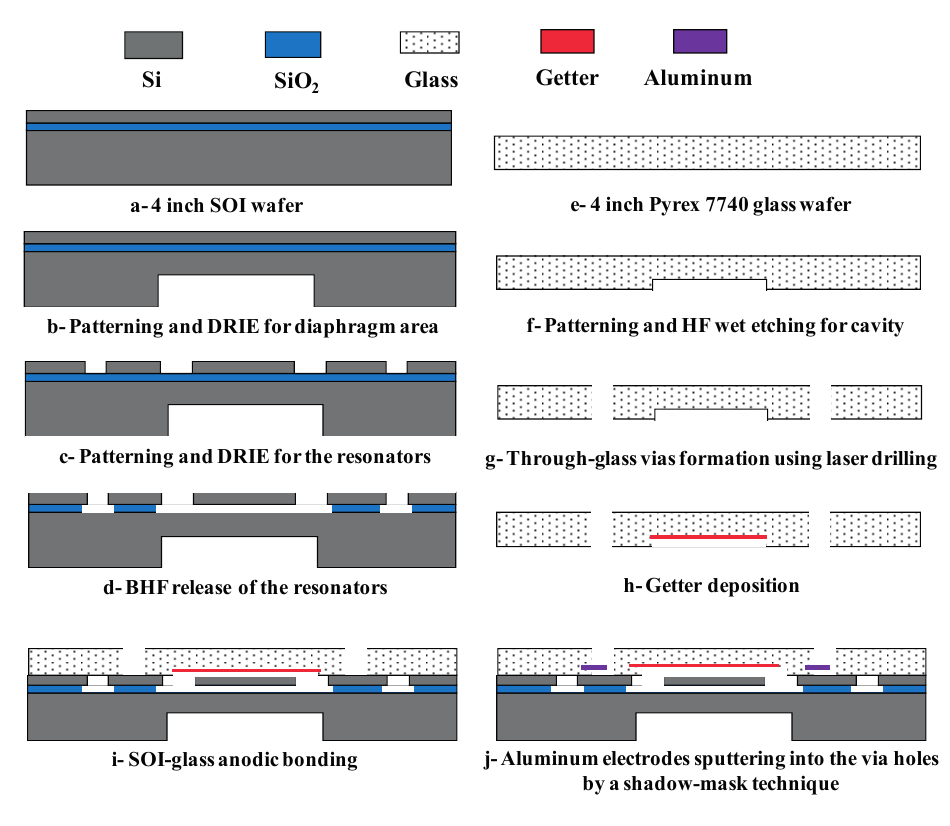
Figure 4. The fabrication procedure for the resonant pressure micro sensor, relying on SOI-MEMS fabrication